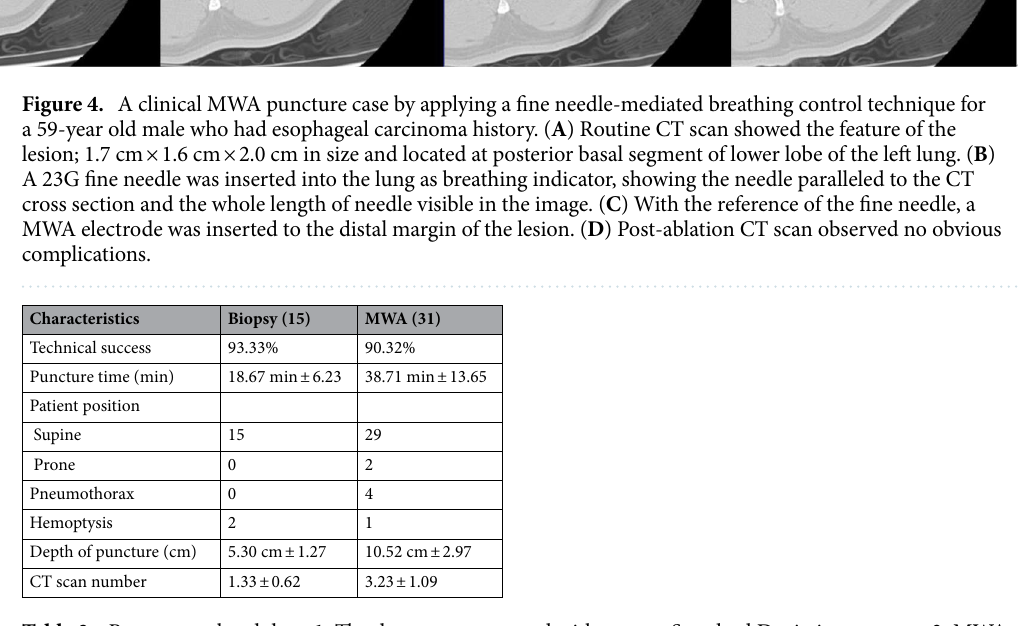
Table 2. Puncture-related data. 1. The data were presented with mean ± Standard Deviation or cases. 2. MWA, microwave ablation.